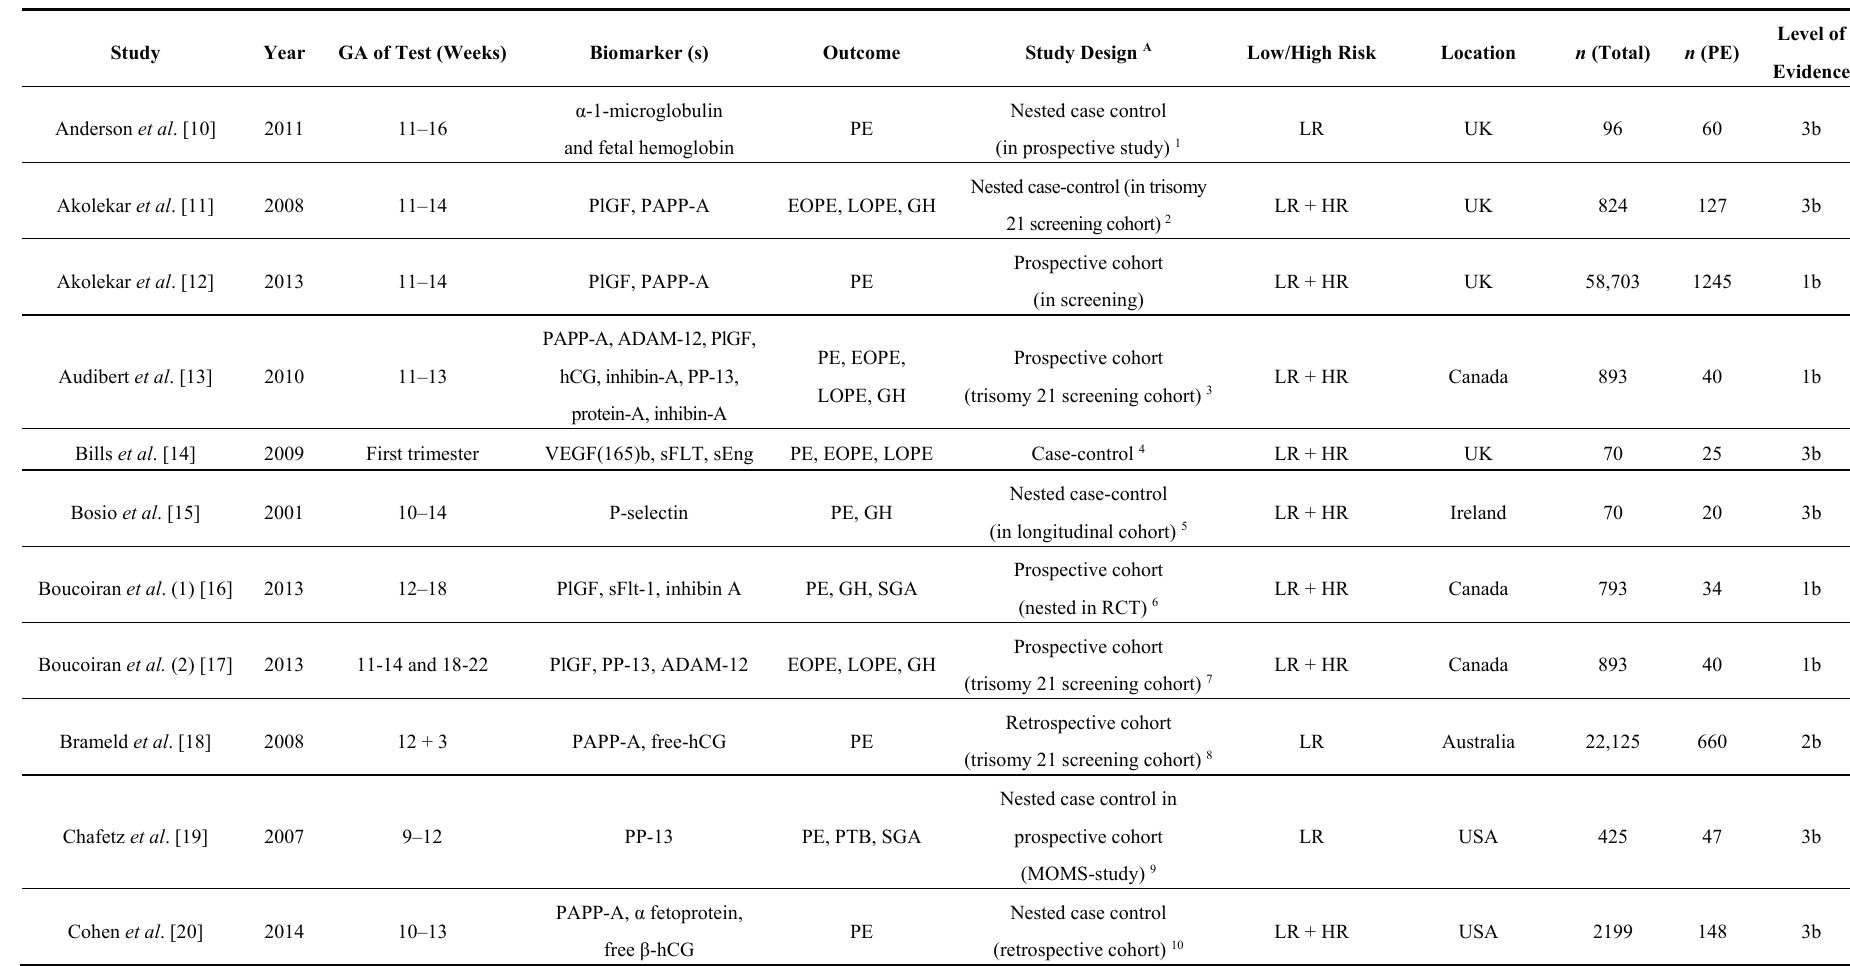
Table 1. General characteristics of the included studies in the meta-analyses. GH: gestational hypertension; SGA: small for gestational age. PTB: preterm birth. The outcomes used were in line with the definitions from International Society for the study of Hypertension (ISSHP)